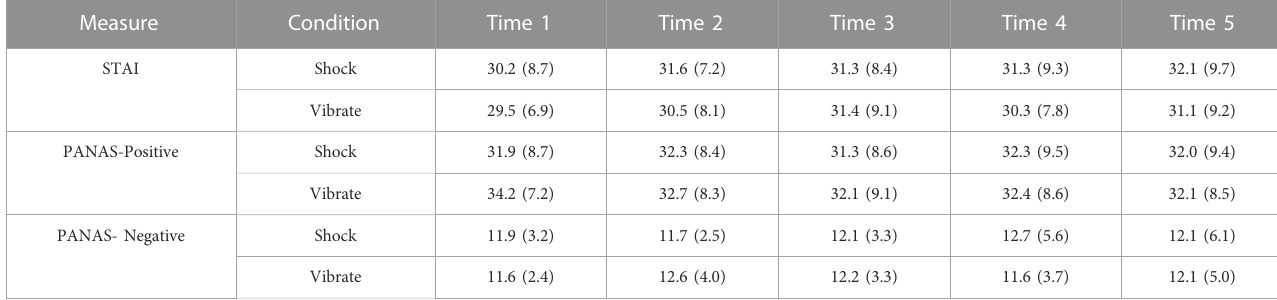
TABLE 3 Mean and standard deviation scores from the STAI and PANAS, at each of the fi ve time points.